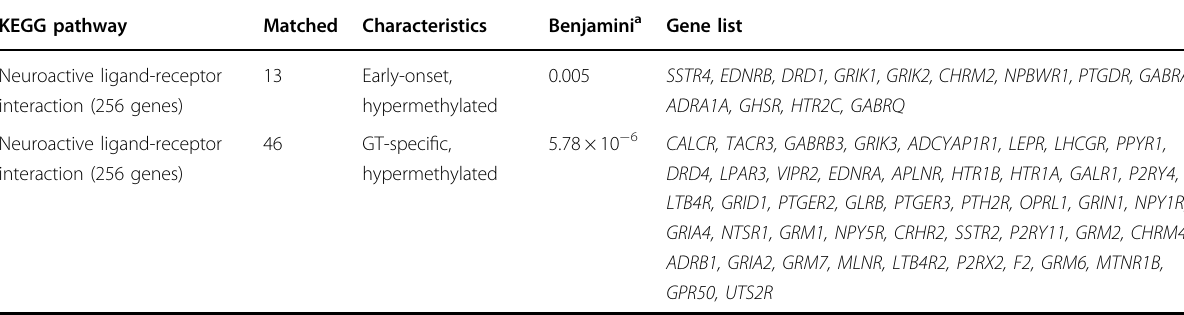
Table 1 Pathway enrichment analysis of all genes selected from the MBD-seq and RRBS analyses KEGG pathway